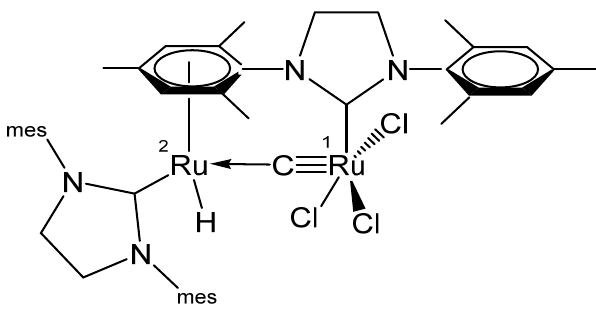
Figure 24. The NHC [RuCl 3 ] - C core.